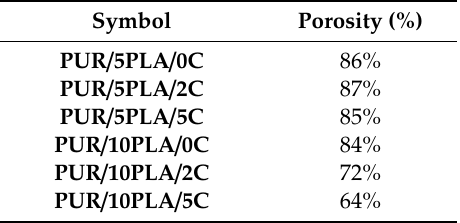
Table 2. Porosity of unmodified and Cipro-modified HPPS.